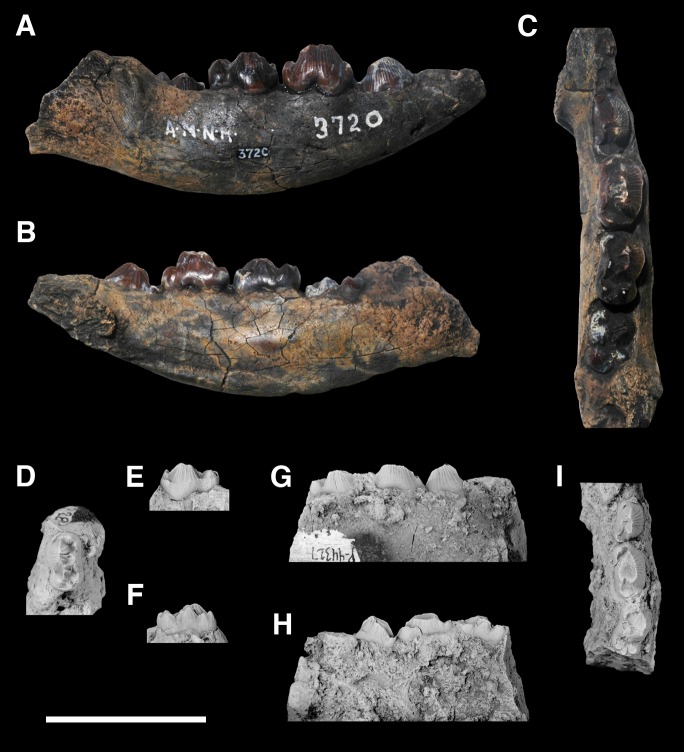
Lower deciduous dentition of Periptychus carinidens.AMNH 3720, a left dentary with dp2, dp4-5 and a partially erupted m1 (A-C): (A) buccal view, (B) lingual view; (C) occlusal view. NMMNH P-2870, an isolated left dp5 (D-F): (D) occlusal view; (E) buccal view; (F) lingual view. NMMNH P-44327, a partial right dentary with dp2-5 (G-I): (G) buccal view; (H) lingual view; (I) occlusal view. Scale bar: 30mm.